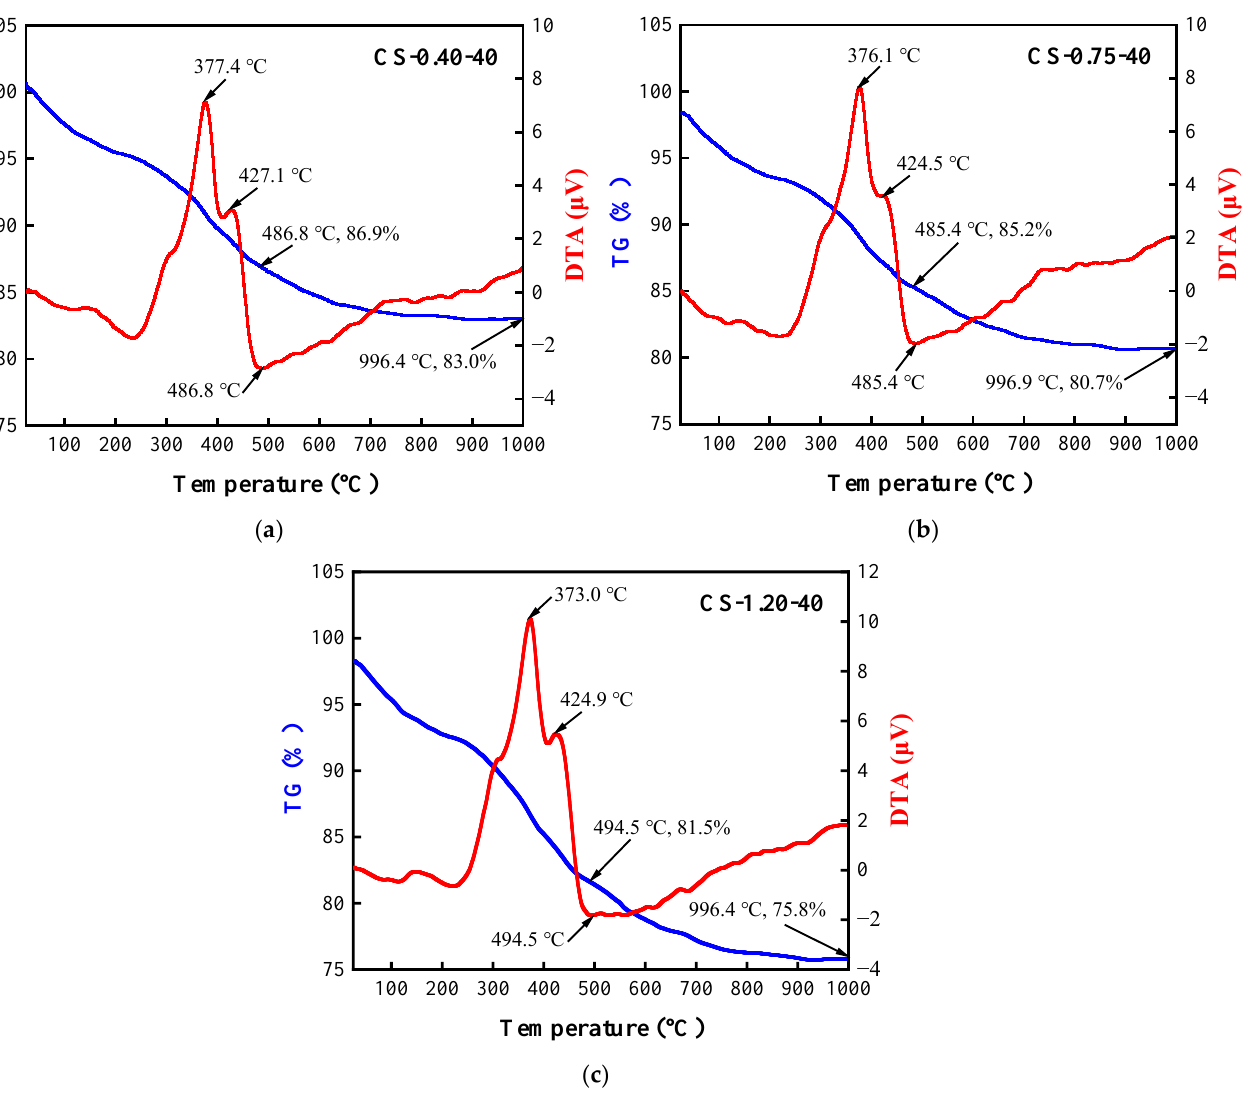
Figure 16. TG/DTA curves of AAM pastes cured at 40 °C for 28 days: ( a ) CS-0.40-40; ( b ) CS-0.75-40; ( c ) CS-1.20-40.